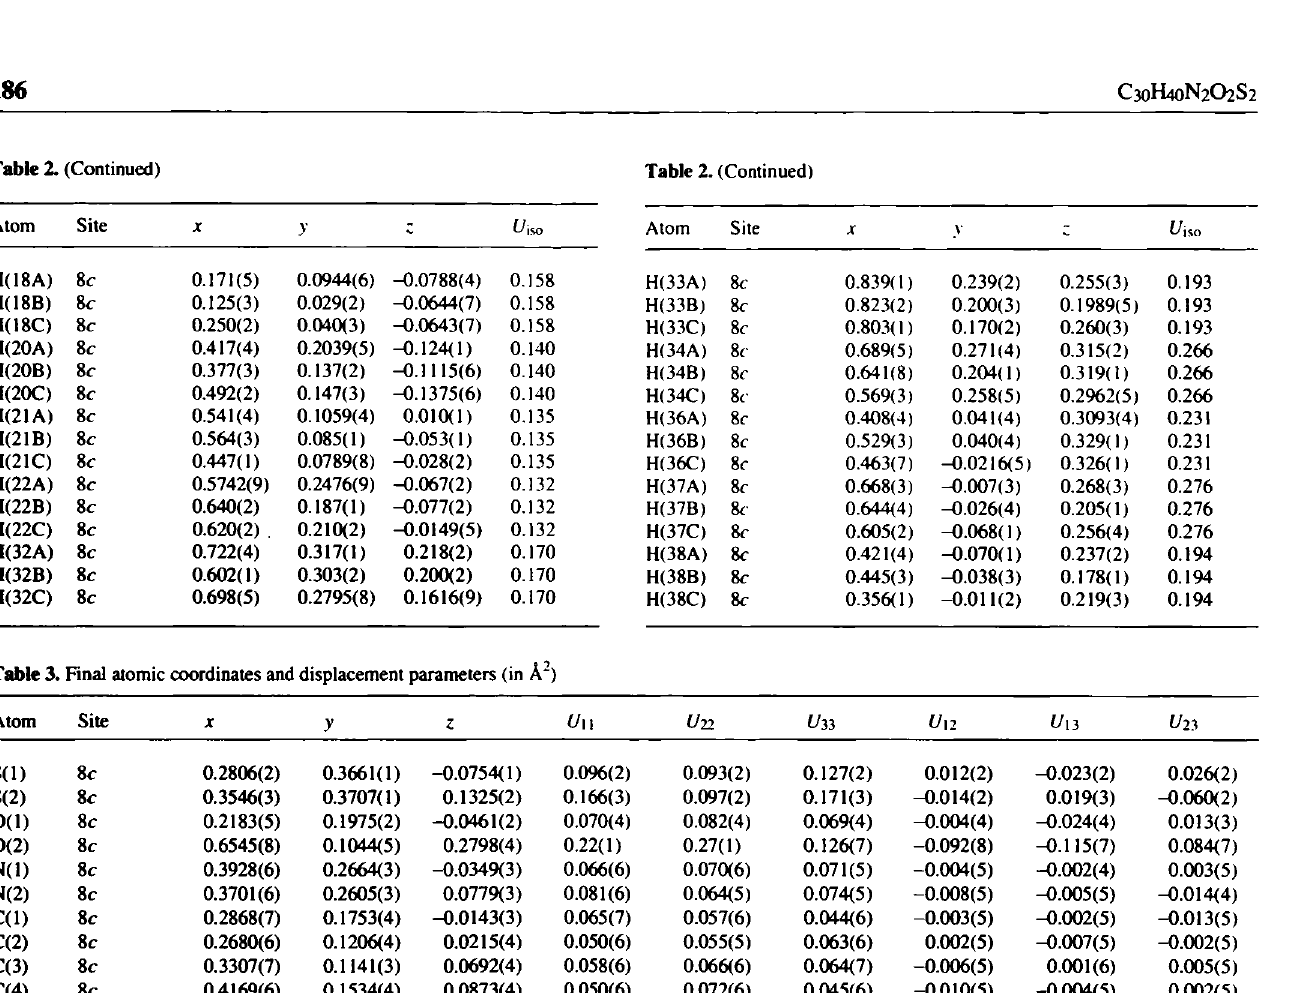
Table 3. Final atomic coordinates and displacement parameters (in